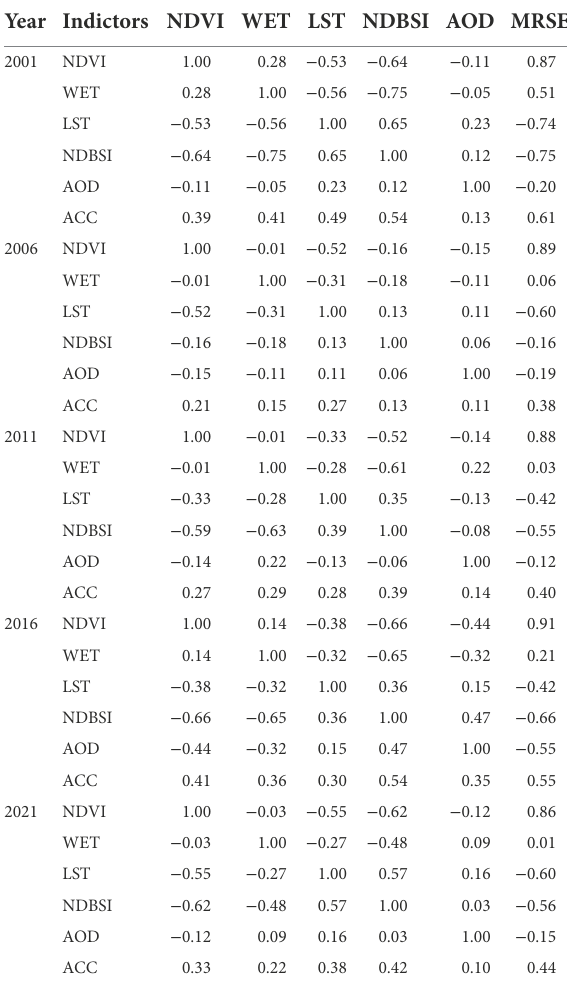
TABLE 4 Correlation matrix of